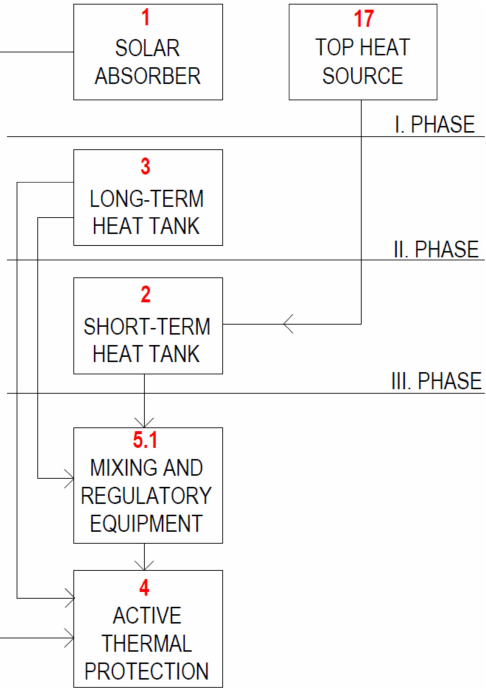
Figure 8. Functional diagram of the operation with active thermal protection